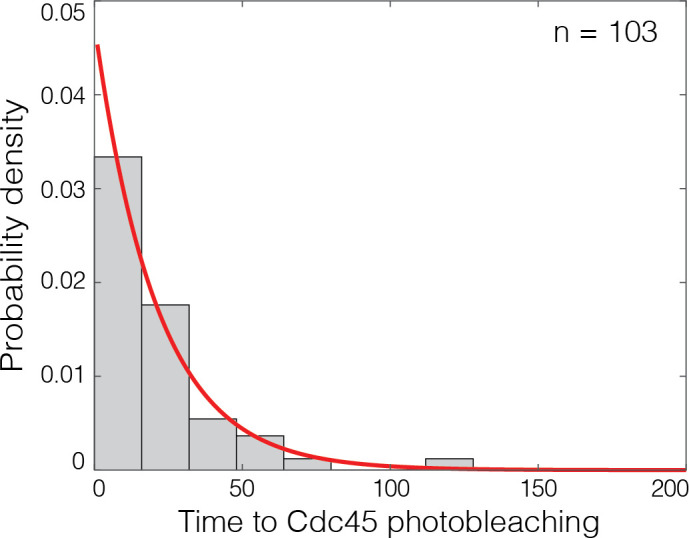
Cdc45SORT649 photobleaching events are temporally resolved.Distribution of time intervals until photobleaching for Cdc45SORT649 bound to DNA with loaded Mcm2-7 prepared at 6.5 nM Dbf4-dependent kinase, as exemplified by the lower-right record in Figure 3B. For records that showed two separate photobleaching steps, the interval was taken to be the time from the first to the second bleaching step. Exponential fit (line) yielded time constant τ = 21 s. This implies that only a small fraction (less than exp (−3 τ Δt)=7%) of sequential photobleaching steps were mistakenly counted as one rather than two steps based on the conservative assumption that all steps separated by three or more Δt = 2.6 s video frame intervals were resolved.